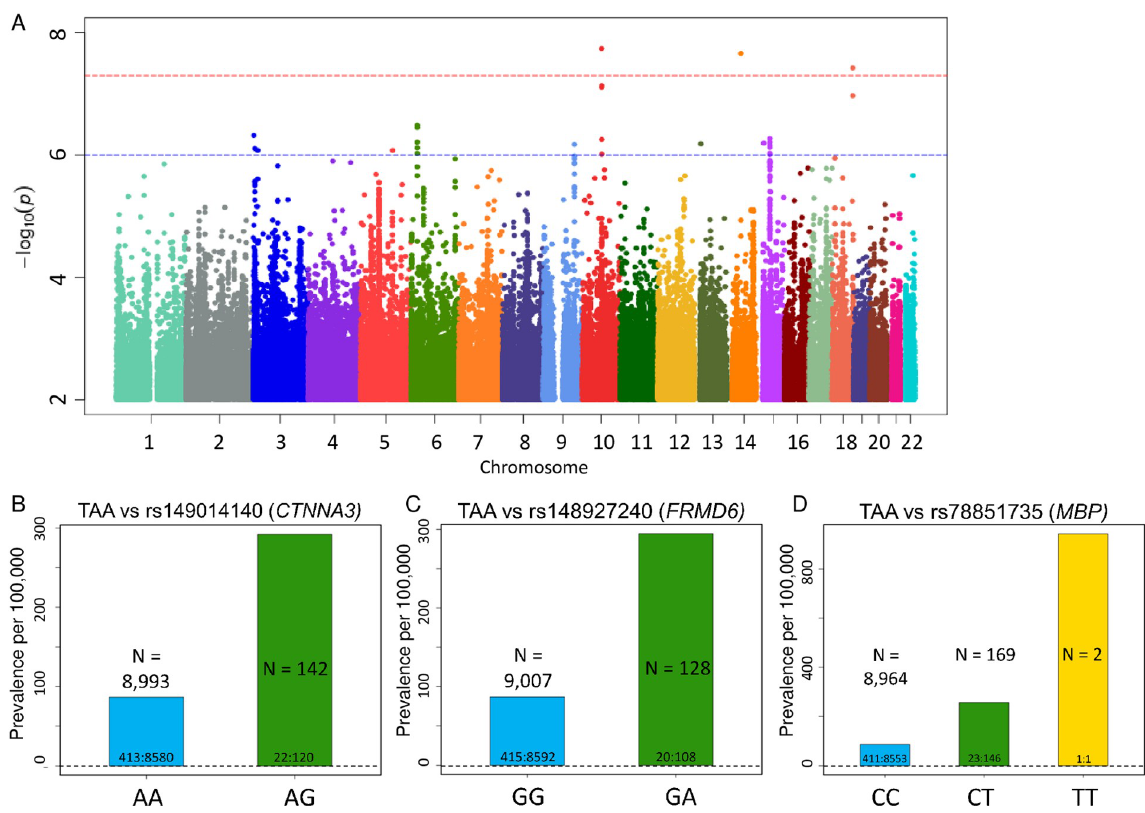
Fig 2. Top SNPs associated with TAA. (A) Manhattan plot of GWAS results (MAF > 0.5%) for TAA. (B-D) Prevalence of thoracic aortic aneurism (AAA) per 100,000 participants in the UK Biobank by genotype. Bars labeled with ratio of cases: Controls. (B) Prevalence of TAA increases with CTNNA3 variant rs149014140 status (P-value = 1.82x10 -8 , OR per G allele = 4.268). (C) Prevalence of TAA increases with FRMD6 variant rs148927240 status (P-value = 2.19x10 -8 , OR per A allele = 4.23). (D) Prevalence of TAA increases with MPB variant rs78851735 status (P-value = 3.79x10 -8 , OR per T allele =